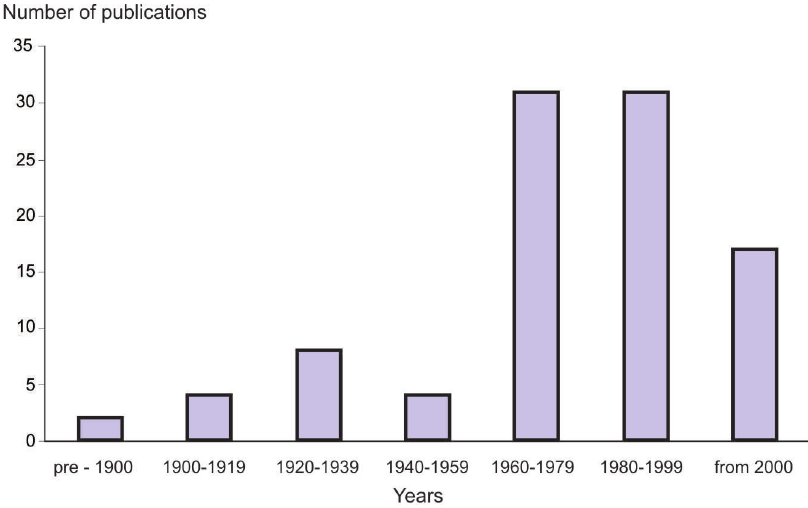
Figure 1. Number of publications concerning subterranean aquatic fauna of Poland through